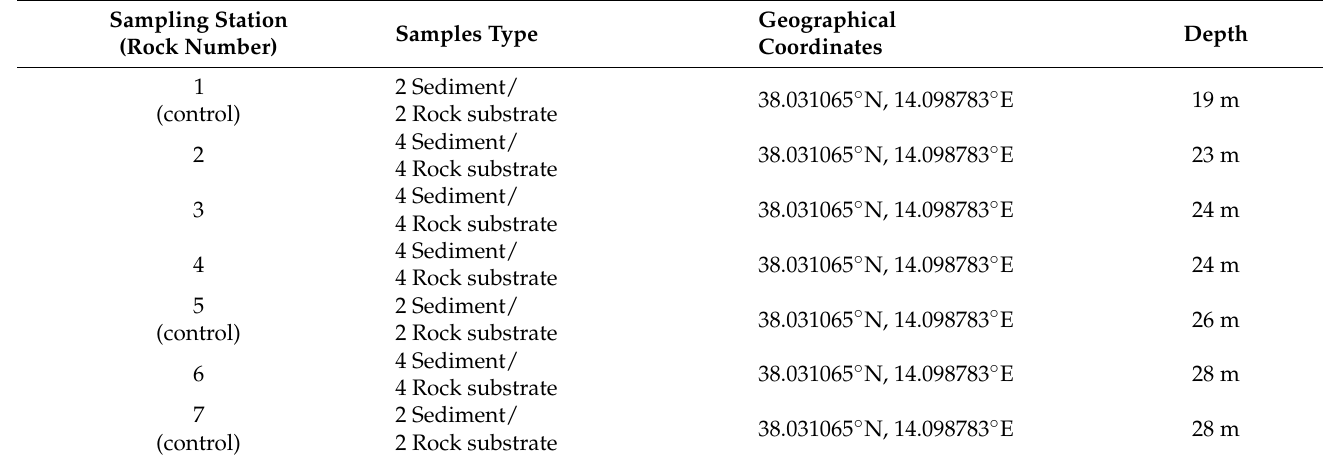
Table 1. Data reported for sampling